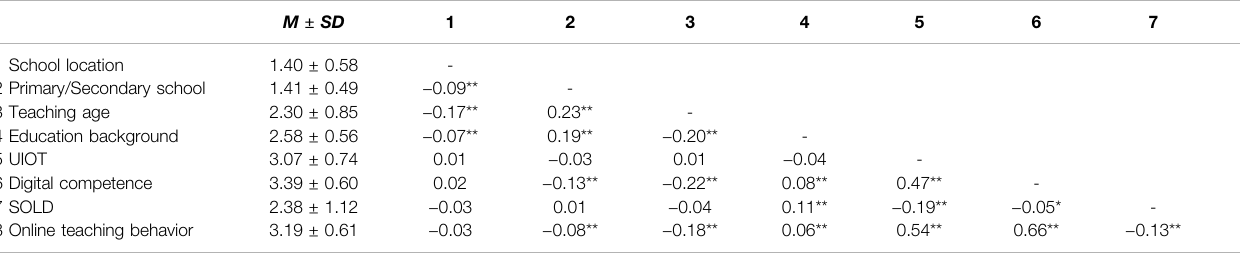
TABLE 1 | Descriptive statistics and correlation matrix of research